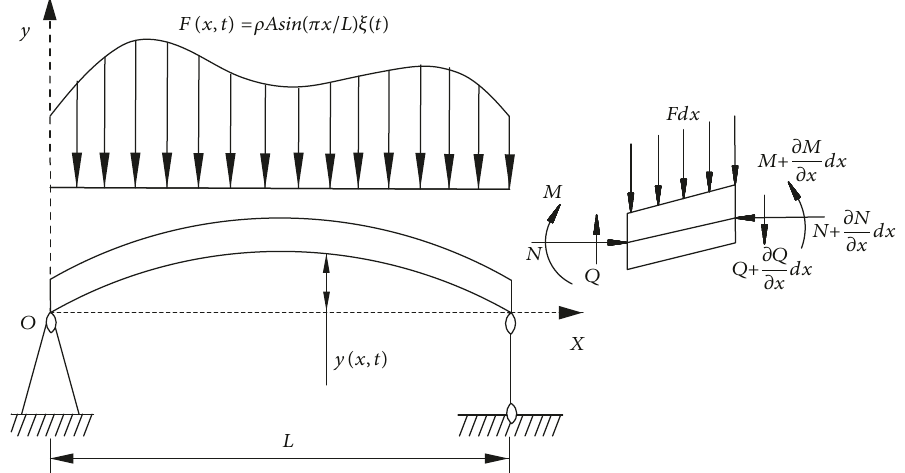
Figure 1: Schematic stress diagram of viscoelastic